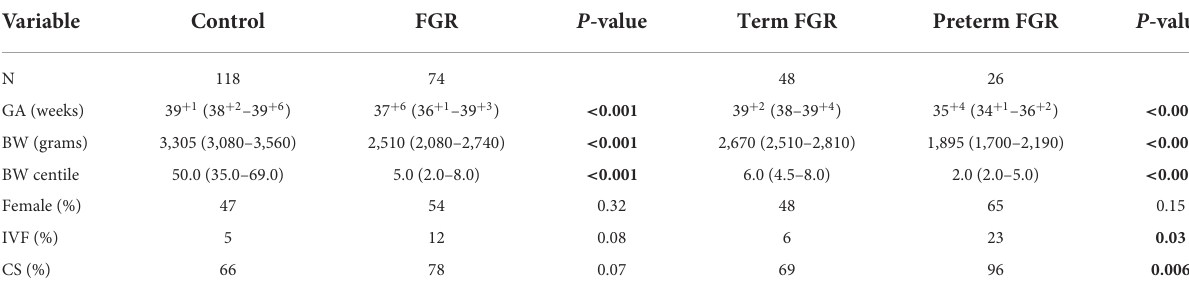
TABLE 1 Demographic data of control, FGR, term FGR, and preterm FGR neonates.